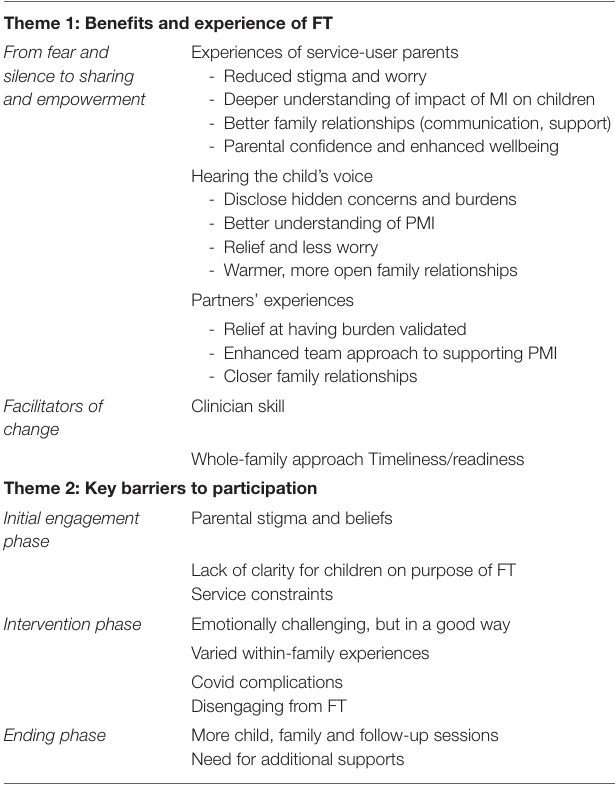
TABLE 3 | Qualitative themes and subthemes of family experiences of Family